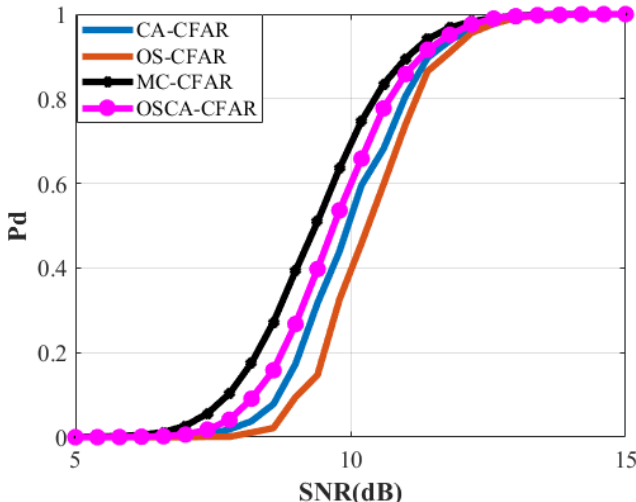
Figure 13. The relationship between detection probability and